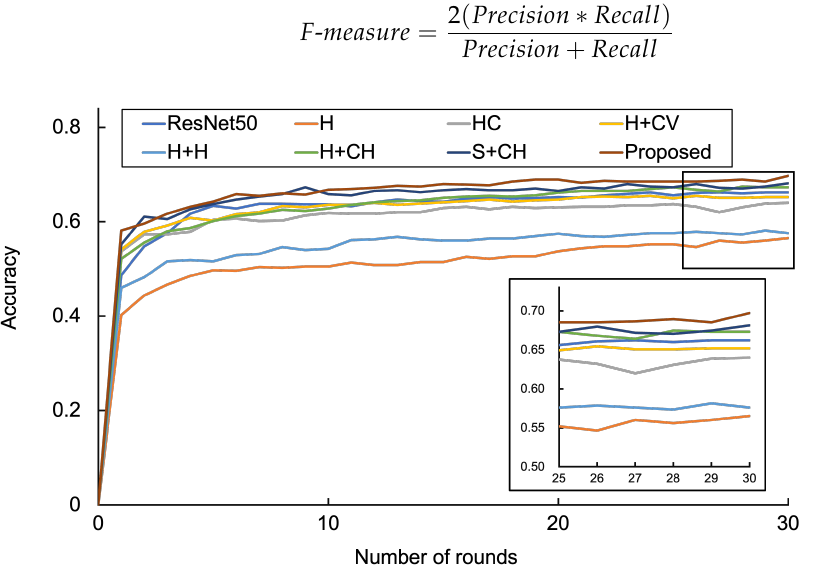
Figure 5. Validation accuracies of the